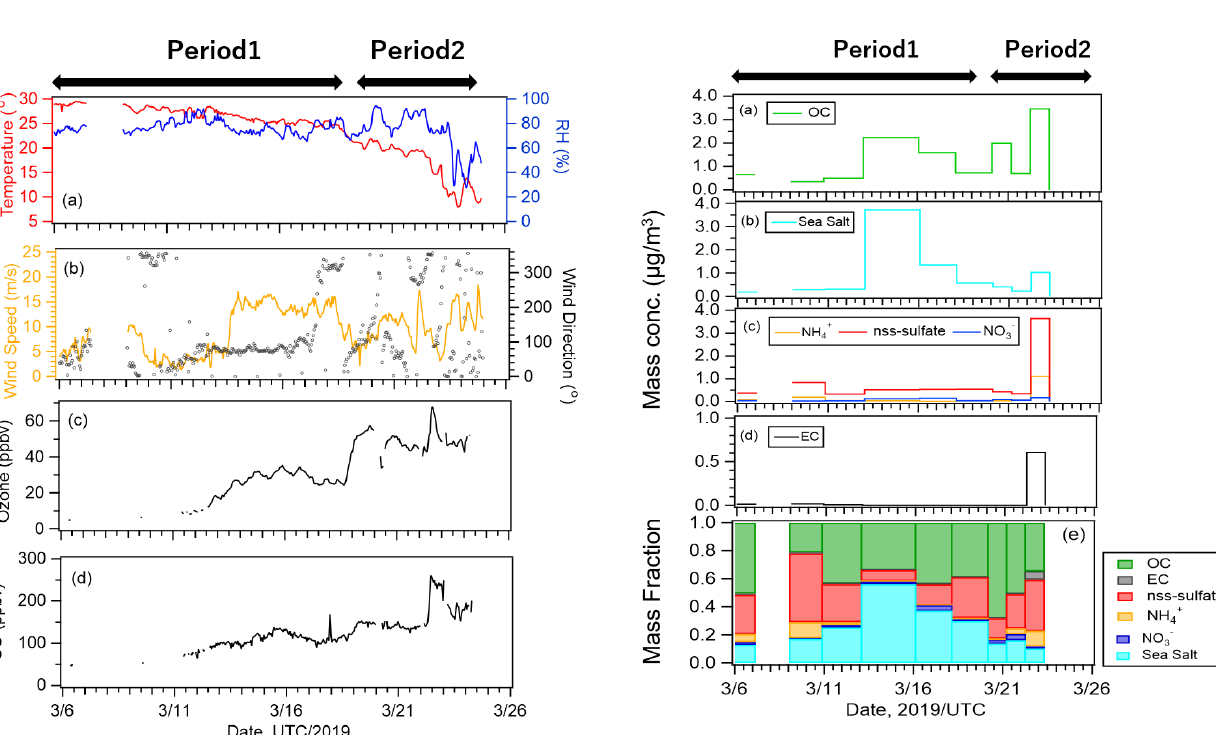
Figure 2. Time series of meteorological parameters: (a) air tem- perature and relative humidity; (b) wind speed and direction. Time series of concentrations of (c) ozone and (d) carbon monoxide.